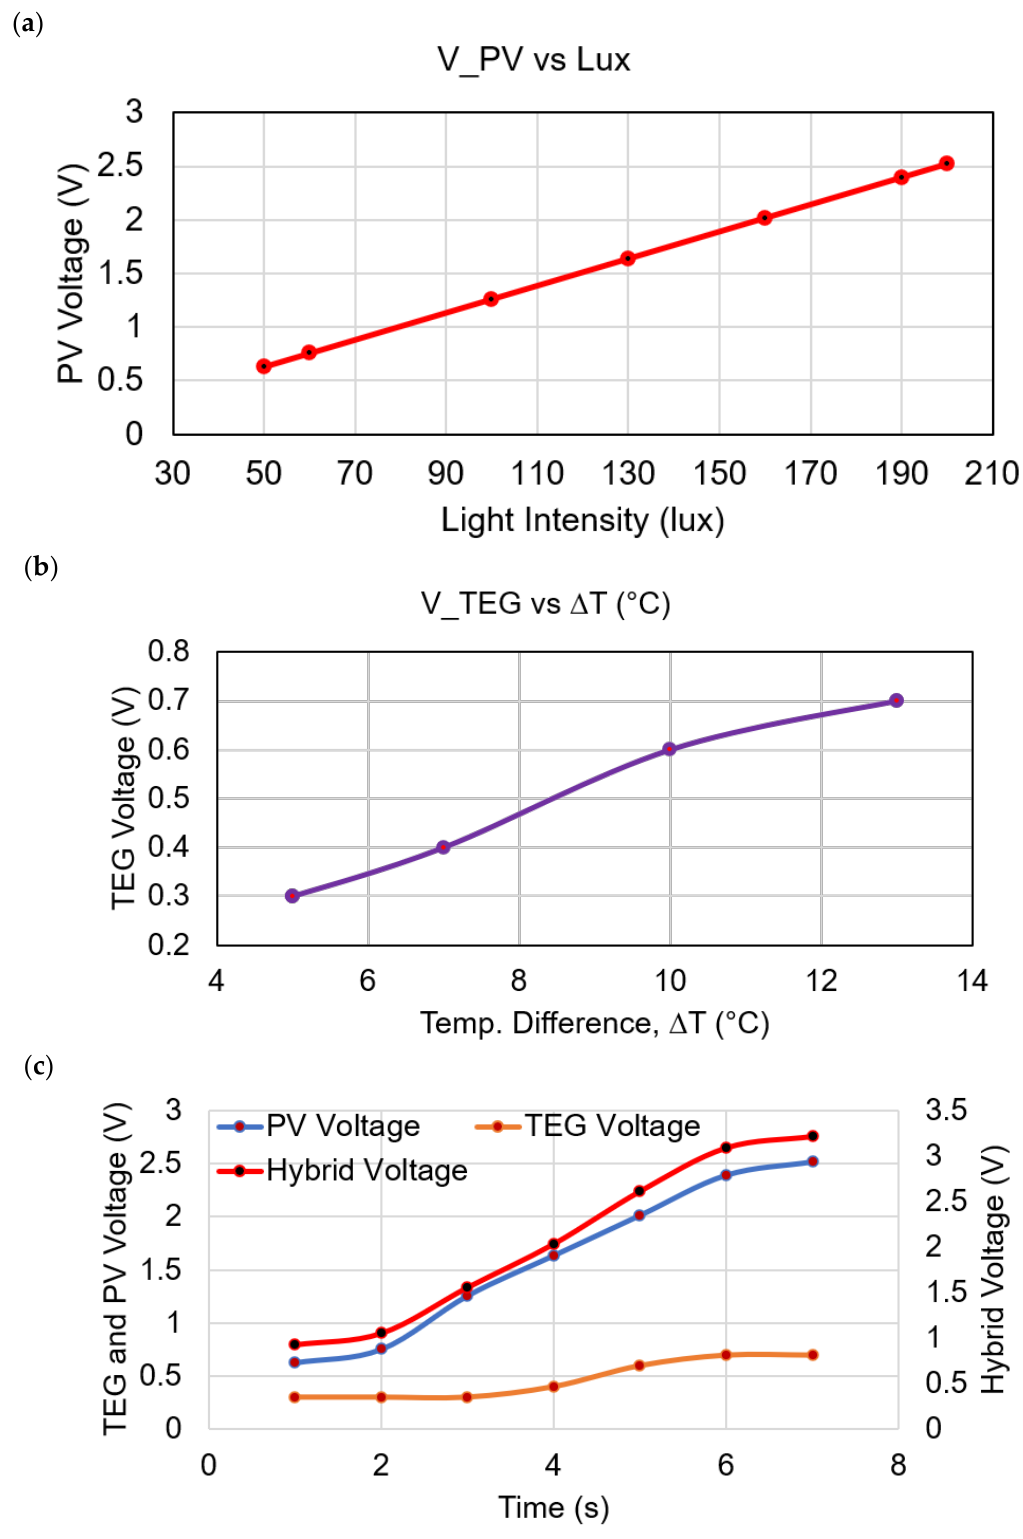
14 of 21 ( c ) Figure 10. Simulation results ( a ) hybrid output curve of the proposed system; ( b ) boost converter output curve; ( c ) the SC output voltage, current and SOC (%). In the prototype, both solar cell and TEG are connected to the V in (J11 pin) of the ADP5091 HEH module. V in is internally connected to the cold start charge pump and the maximum power point tracking (MPPT) pin. The MPPT pin ’ s output is connected to the boost controller, and the boosted voltage delivered to the BAT (J7 pin) of the HEH device. The BAT pin is directly connected to the supercapacitor (SC). The minimum and maxi- mum input voltage of the ADP5091 is 0.8 V and 3.3 V, respectively. From the experiment, it is shown that the SC starts to charge when the energy sources generate only 0.8 V. In the investigation, the different input voltage level of 0.8 V to 3.2 V is tested. Figure 11a shows the PV cell generated voltage at different light intensity. In indoor environment, at minimum 50 lux of a LED lamp the PV cell can generate 0.63 V and at maximum 200 lux